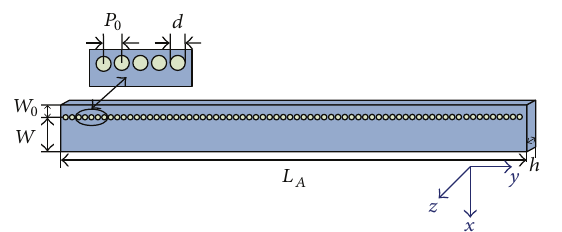
Figure 1: Structure of the HMSIW LWA, 𝐿 𝐴 = 136 mm, ℎ = = 1.5 mm, 𝑃 = 2 mm, and 𝑑 = 1 mm. 1.57 mm, 𝑊 0 0